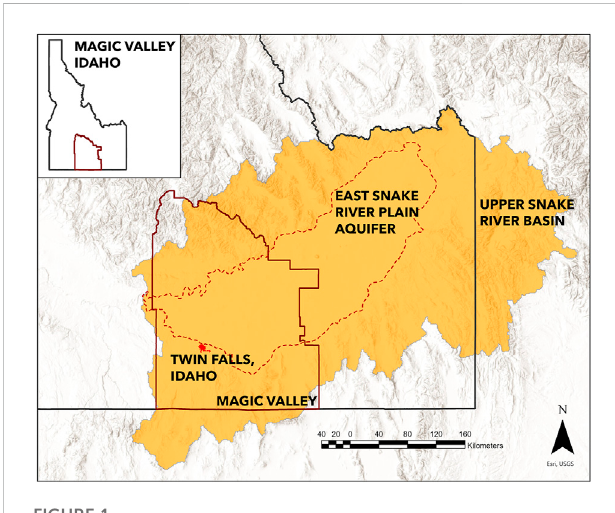
FIGURE 1 Location map of the Upper Snake River Basin and the Magic Valley (outlined in maroon), Idaho, United States of